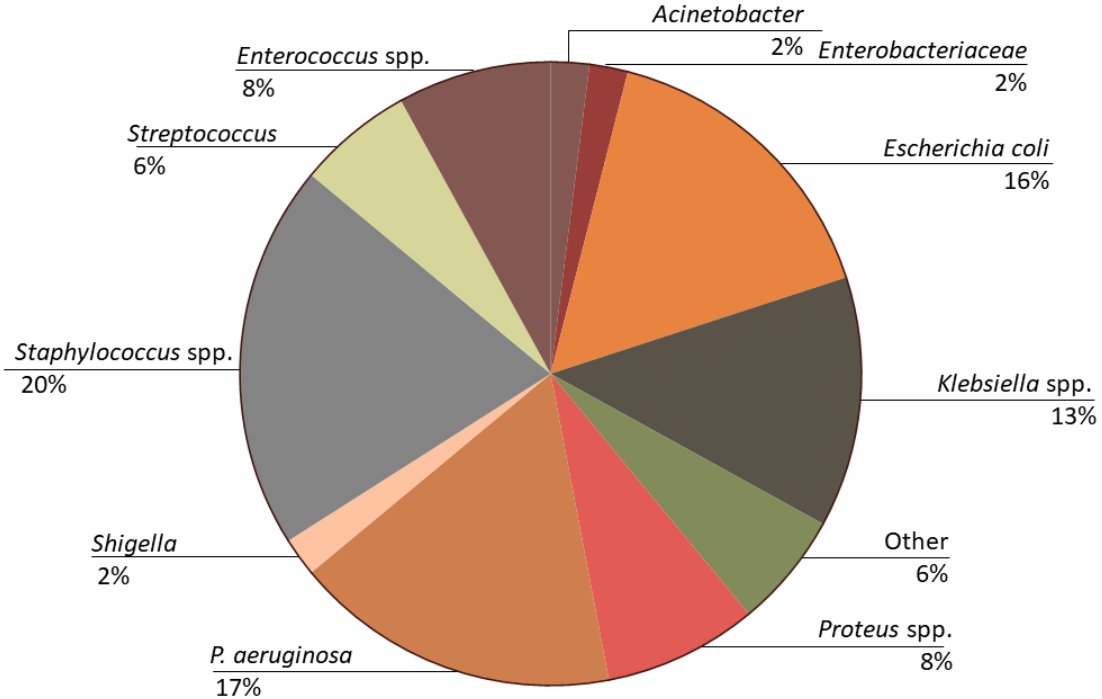
Figure 3. Bacterial species addressed by clinical trials. Many of the currently registered clinical trials on clinicaltrials.gov address an ESKAPE pathogen ( E. faecium , S. aureus , K. pneumoniae , A. baumannii